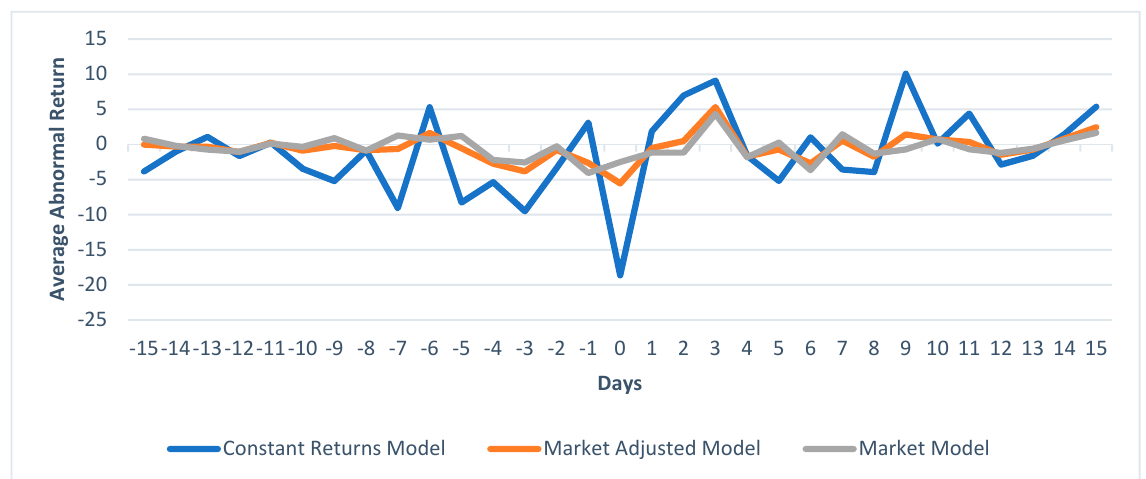
Figure 5. Event period AAR for the financial services sector (source: the authors).